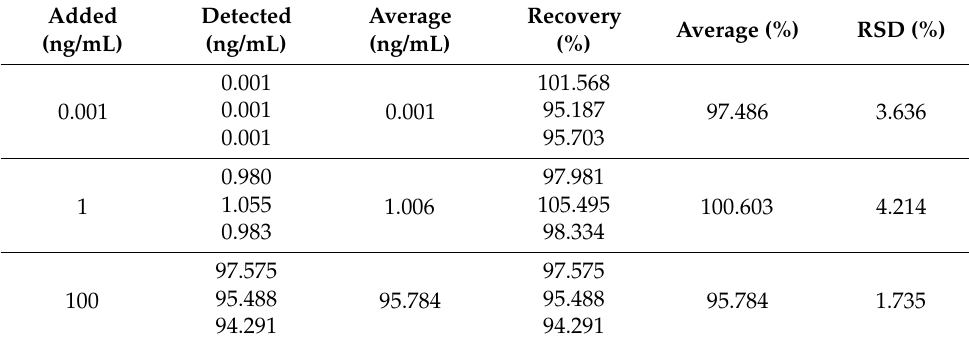
Table 2. Recovery experiment of OTA in coffee